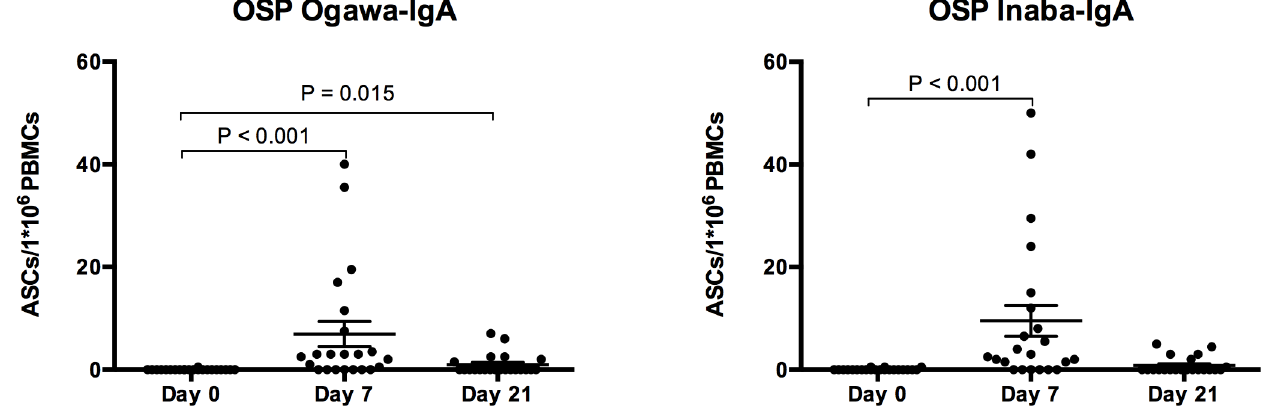
Fig 2. Ogawa and Inaba O-specific polysaccharide (OSP) Immunoglobulin A (IgA) Antibody secreting cell (ASC) responses in vaccinees. Individual and mean circulating antigen-specific IgA responses to Ogawa and Inaba OSP with standard error bars. P values are indicated where statistically significant differences from baseline (Day 0) are